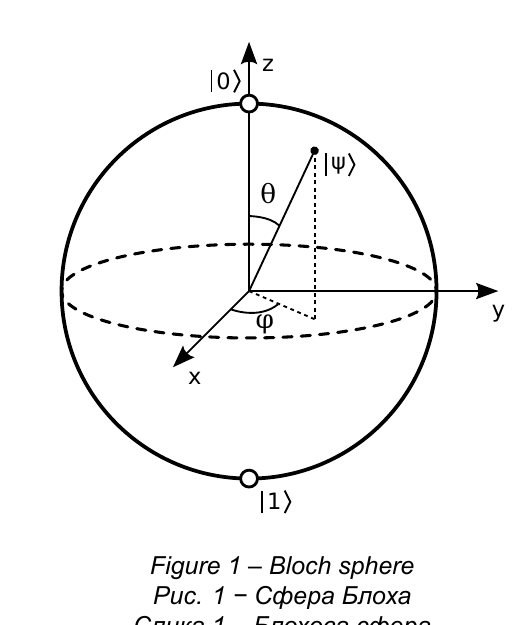
Figure 1 – Bloch sphere Рис. 1 − Сфера Блоха Слика 1 – Блохова